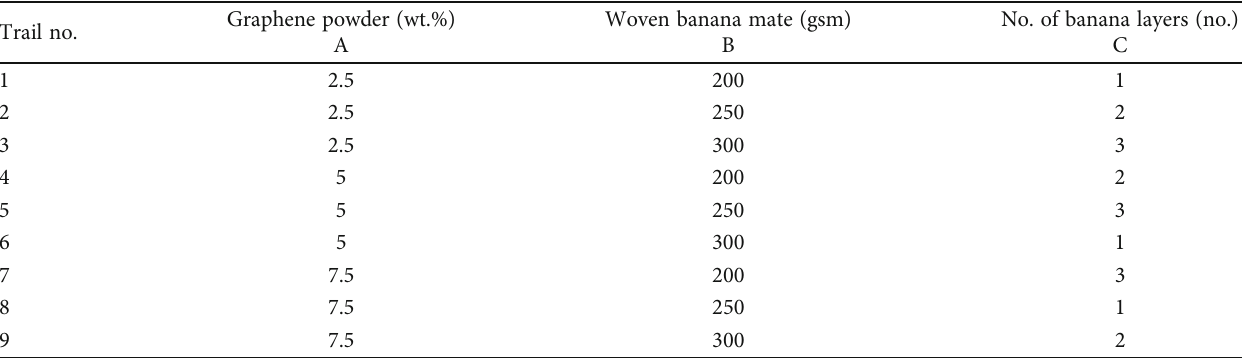
Table 2: L orthogonal array of hybrid composites. 9